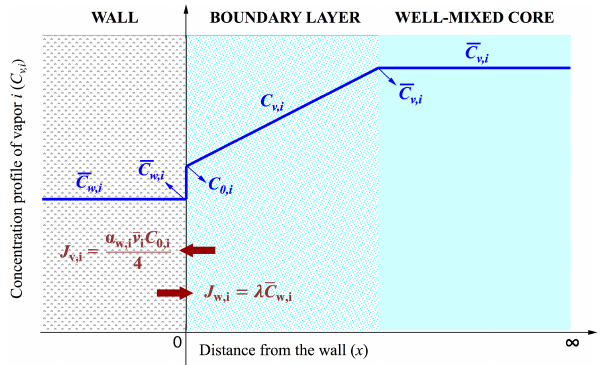
Figure 1. Theoretical framework representing the vapor–wall inter- actions. Concentrations of organic vapor i in the well-mixed core, in the boundary layer, over the surface of the chamber wall, and in the chamber wall are denoted by ¯ C v ,i , C v ,i , C 0 ,i , ¯ C w ,i , respectively. Vapor fluxes at the gas–wall interface are denoted by J v ,i and J w ,i .